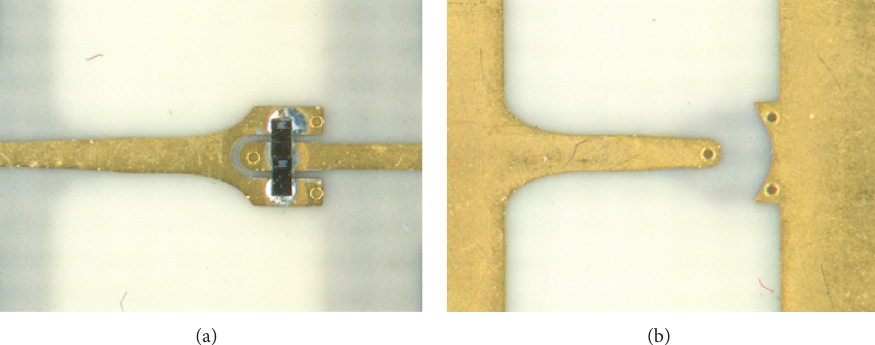
Figure 6: Fabricated wideband frequency tripler (Type B): (a) top view and (b) bottom view. The dimension is 300 mil × 250 mil.